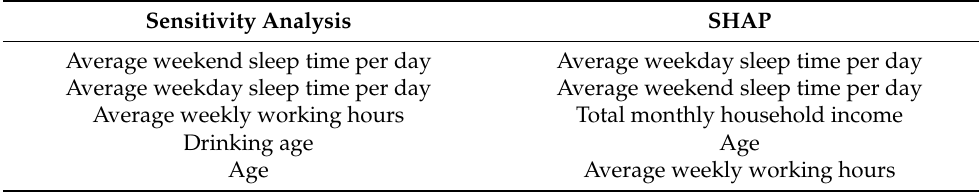
Table 12. The top 5 significant features of the sensitivity analysis for hepatitis B risk association model.